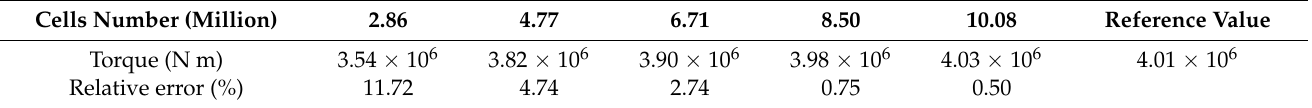
Table 2. Torque of different gird